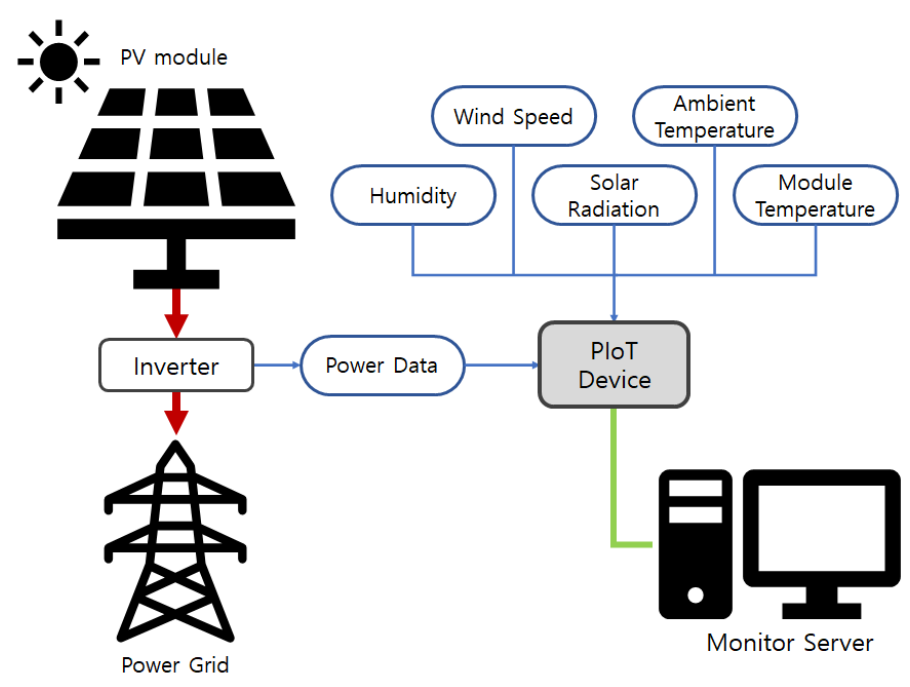
Figure 1. Photovoltaic power generation system with PIoT